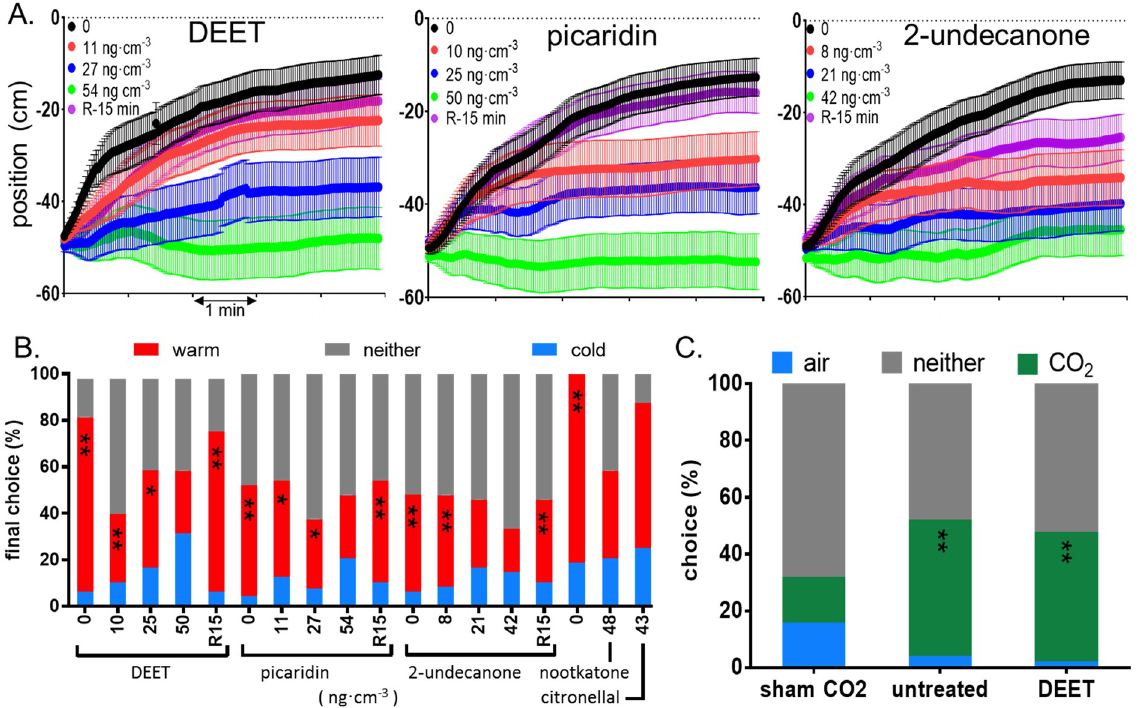
Fig 7. Disruption of thermotaxis by repellents. (A) Mean longitudinal position ( ± SEM) in thermotaxis trials of unfed virgin adult A . americanum females exposed to the indicated repellent vapor concentrations (ng•cm -3 ) or after 15 minutes’ recovery from the highest concentration (R). Ticks were placed into the center of the arena, at -50 cm with respect to the 40 ˚C target wall. (B) Final position after 5 minutes, scored as in Fig 5A. (C) Y-tube choice assays with unfed virgin adult A . americanum females under three conditions. Sham CO 2 : both tubes contained pure air. Untreated: air in one tube contained 4% CO 2 . DEET: air in one tube contained 4% CO 2 and all ticks were exposed to 50 ng•cm -3 DEET. Significance of warm/cold or CO 2 /air difference: �� : p < 0.001; � : p < 0.05.